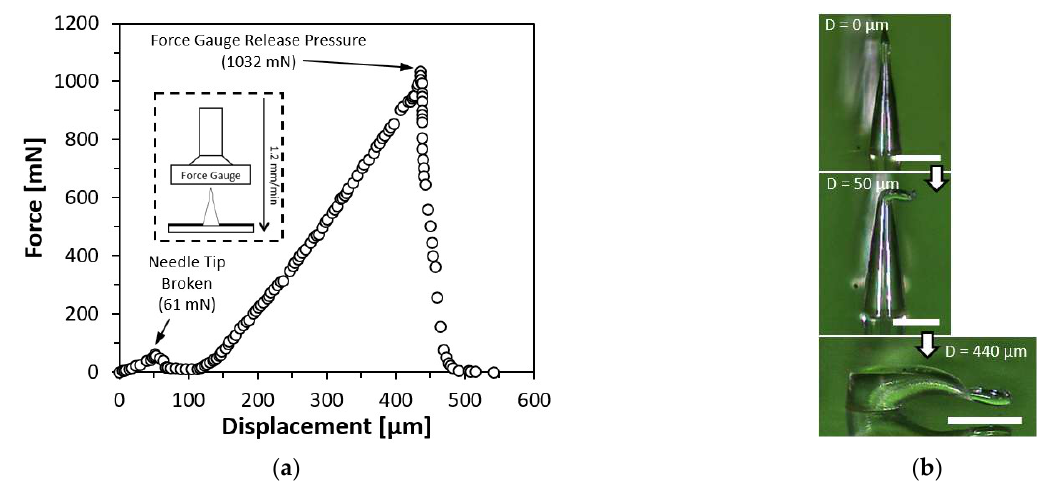
Figure 7. Force-displacement test result on a single PLA straight first bell-tip microneedle. ( a ) Force- displacement test result. ( b ) Compressed microneedle. Scale bar = 200 µm.